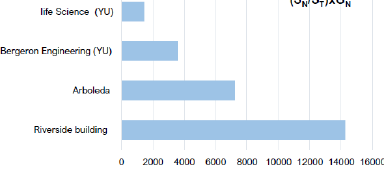
Figure 14: (S N /S T ).G N - Graph-Model Nodes